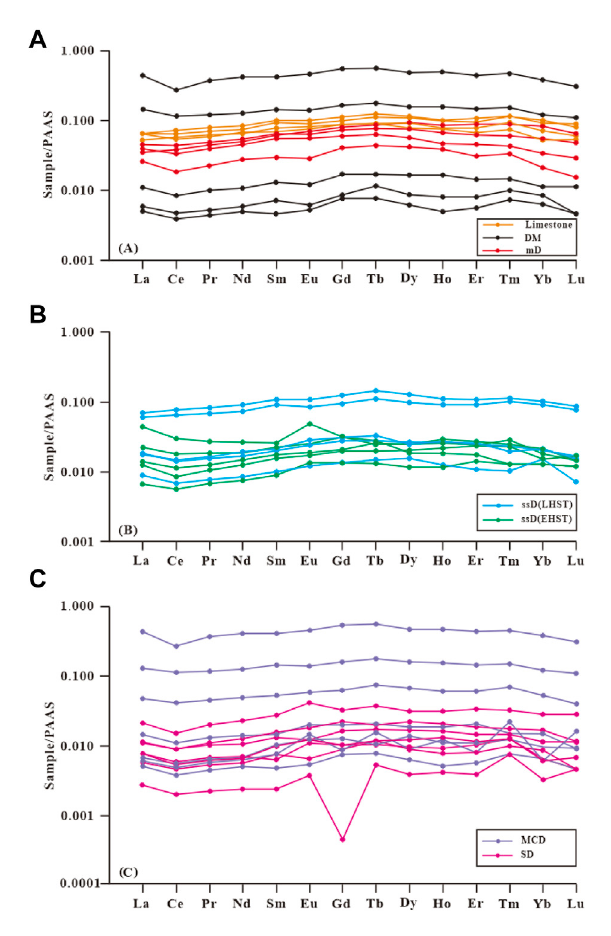
FIGURE 6 Distribution patterns of REEs in the investigated changping formation. (A) REE characteristics of limestone, DM and mD; (B) REE characteristics of ssD in the LHST and EHST; (C) REE characteristics of MCD and SD.